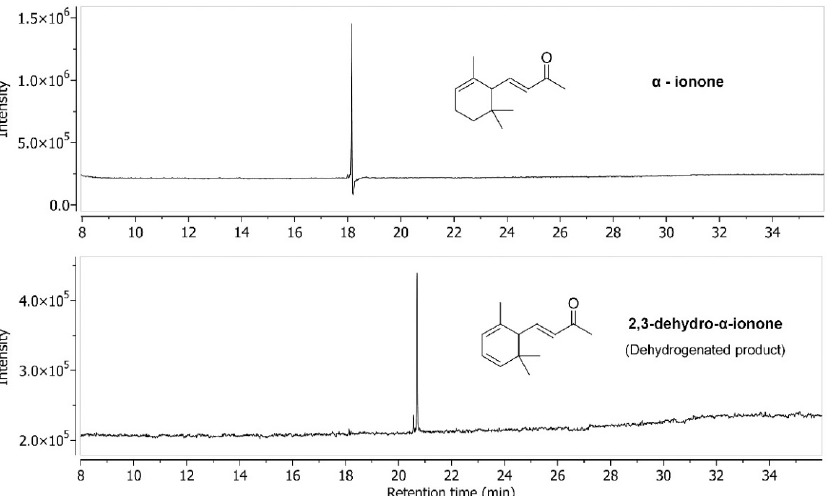
Figure 2. Gas chromatography analysis of the conversion of α -ionone by CYP101D5. The peak (t RS = 18.18 min) is of the substrate and the product peak (t RP = 20.68 min) is identified as 2,3-dehydro- α -ionone. The structures of both the substrate and product are shown. The mass spectra of both the substrate and product are presented in Figure S3.